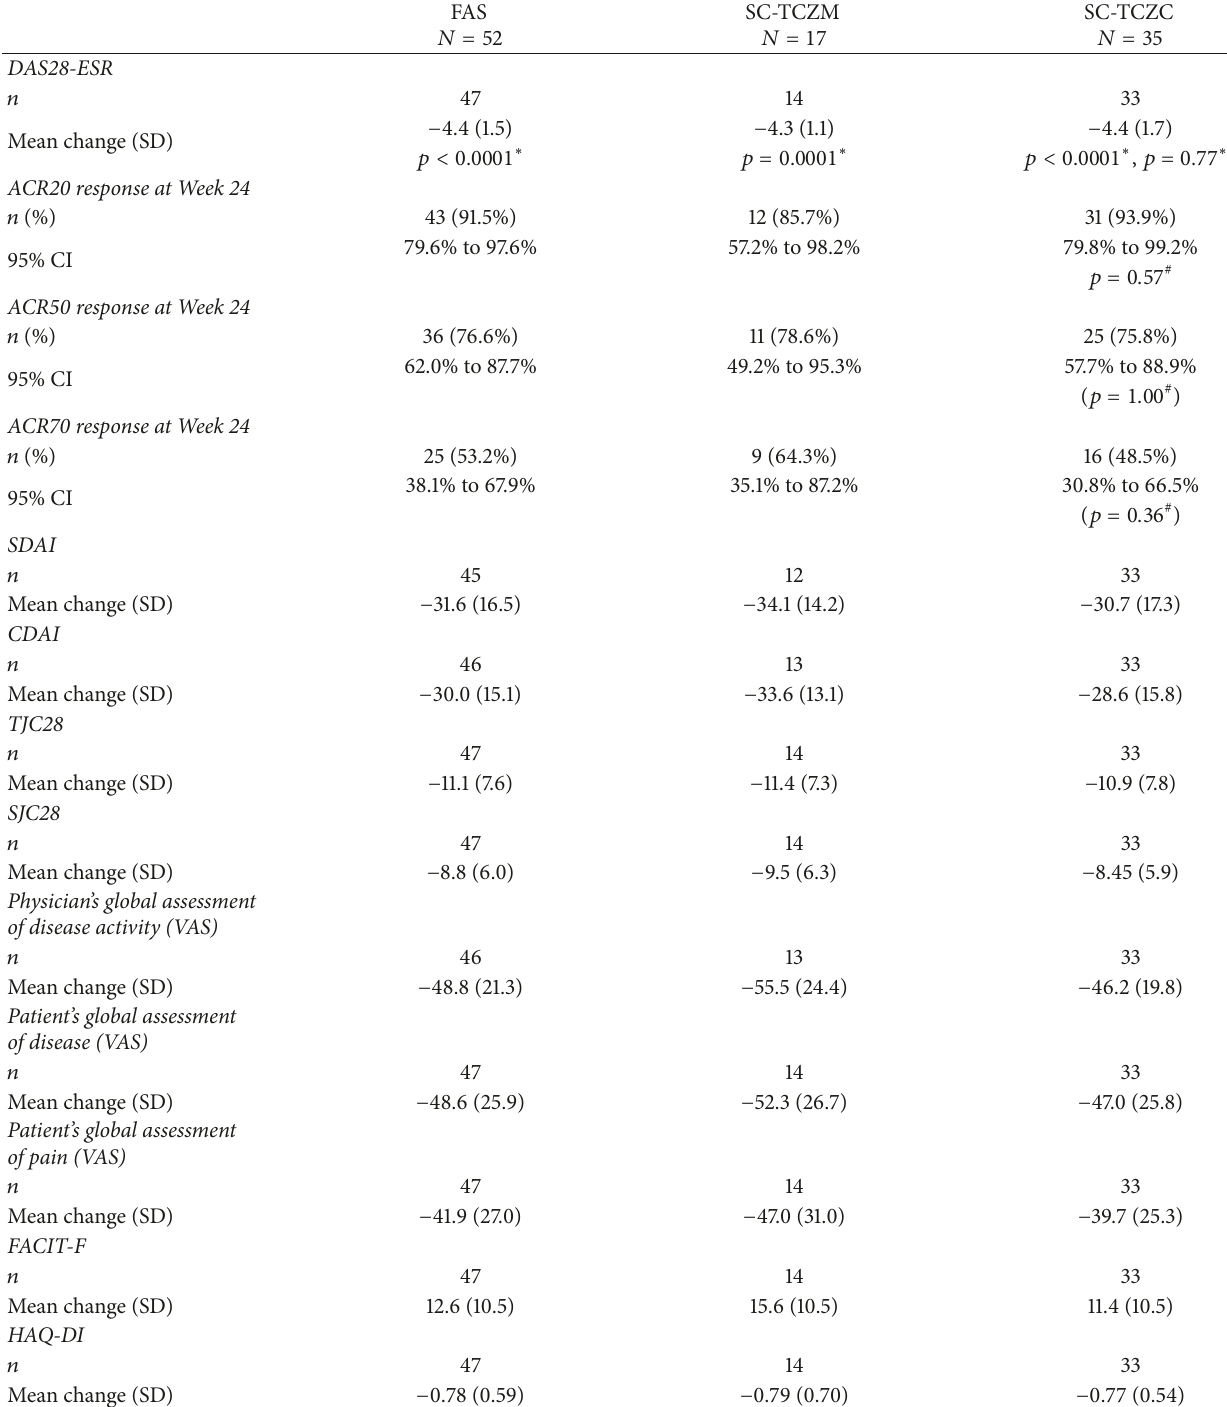
Table 4: Change from baseline to Week 24 in disease activity measures and subject reported